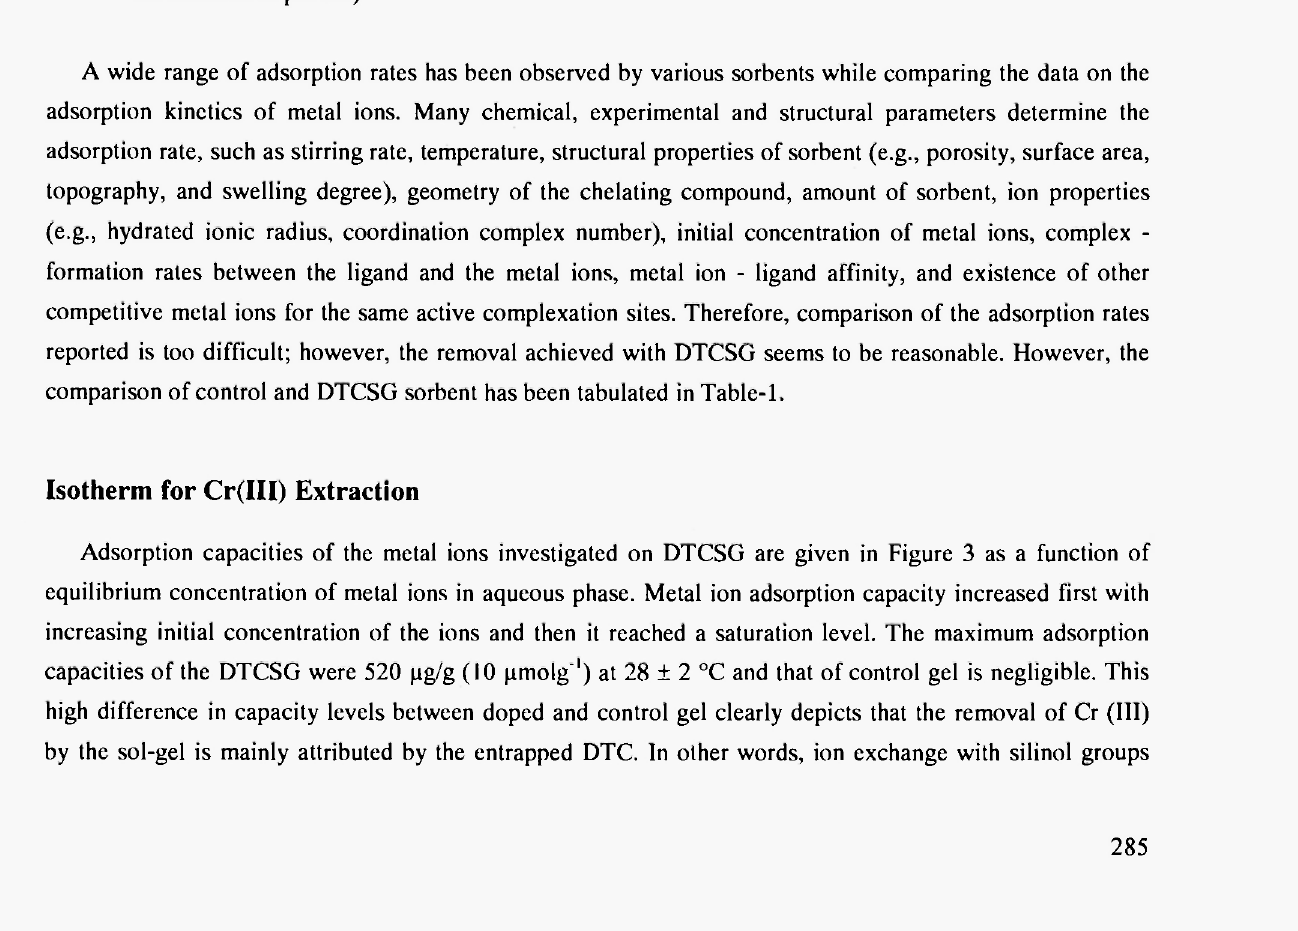
Fig. 2: Removal of Cr(III) vs equilibration time (Cr(III) 3.84 χ 10" 5 M, doped sol-gel = 50 mg, volume = 5 ml buffered at pH